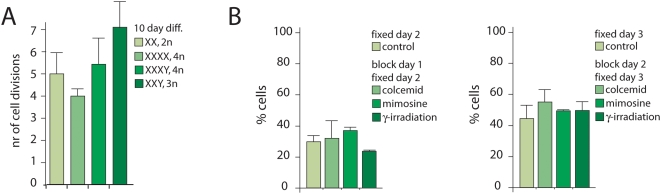
Initiation of XCI independent of cell division.A) Determination of the number of cell divisions during a 10 day EB differentiation period. Shown are the average and standard deviation of two separate experiments with two different ES lines per X∶A ratio or ploidy number. B) Analysis of initiation of XCI after a cell cycle block. Diploid female ES cells were EB differentiated for one day (left graph) or two days (right graph), and treated with colcemid or mimosine, or cells were lethally γ-irradiated, and allowed to differentiate for one more day before fixation. Control samples were allowed to differentiate for two or three days. The percentage of cells that initiated XCI was determined by Xist RNA FISH, followed by the quantification of the number of cells with Xist clouds.